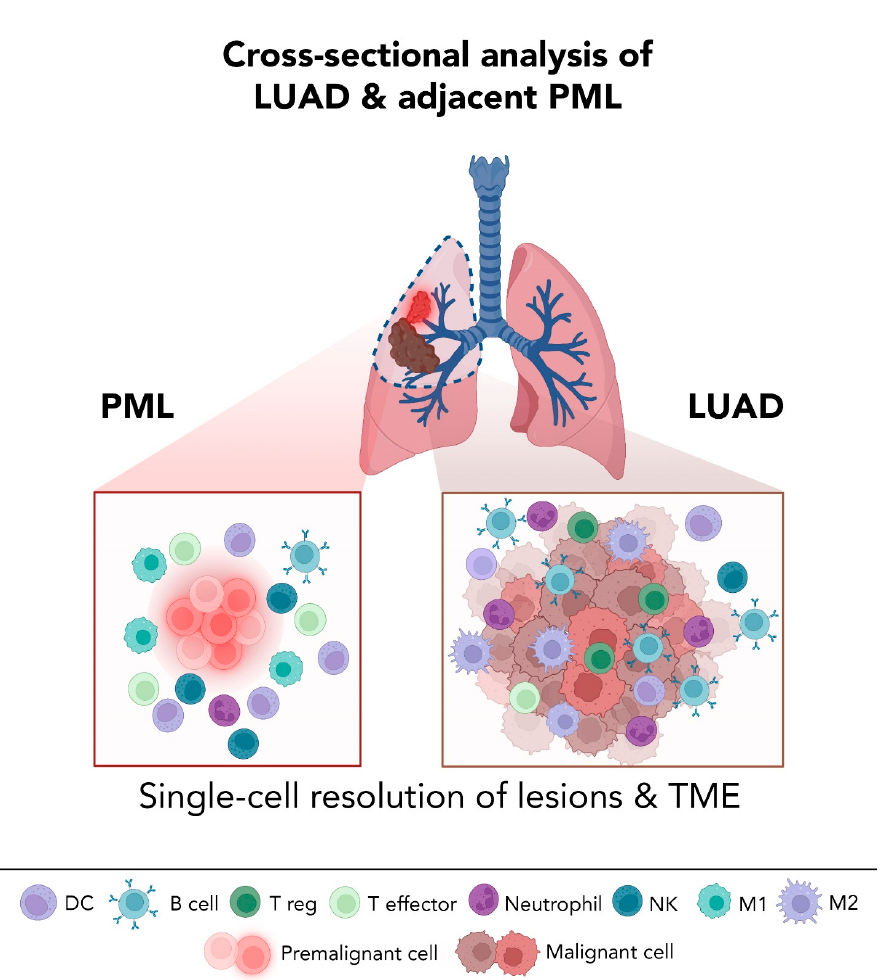
Figure 1. A high-resolution overview of lesions and the TME revealed by cross-sectional single-cell analysis of LUADs and adjacent PMLs found in surgical samples from patients (e.g., lobectomies). Analysis of lesions at single-cell resolution can reveal in-depth insights into the biology of epithelial and non-epithelial (e.g., immune) subsets. This can help delineate the dynamics of epithelial plas- ticity and intra-tumor heterogeneity and point towards possible ways to intercept and impede the development of PMLs and/or their progression to LUADs. PML; premalignant lesion. LUAD; lung adenocarcinoma. DC; dendritic cell. Treg; regulatory T cell. NK; natural killer cell. M1; M1 type macrophage. M2; M2 type macrophage. Created with BioRender.com. Single-cell transcriptomic resolution is also uncovering ITH in LUAD immune and stromal tumor compartments, in addition to epithelial cells. This is not surprising, since it is now well known that the dynamic interplay between cancer cells and the TME plays key roles in cancer pathogenesis [60,61]. For instance, failure of deployment of cytotoxic T-cell lymphocytes (CTLs) that can target tumor cells or suppression of immune